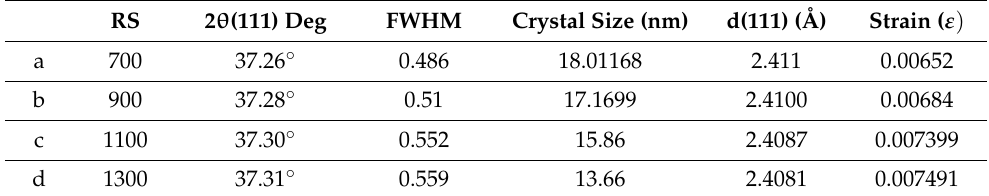
Table 1. Crystal size, d-spacing, and lattice constant of (111) plane NiO thin film prepared at RS of